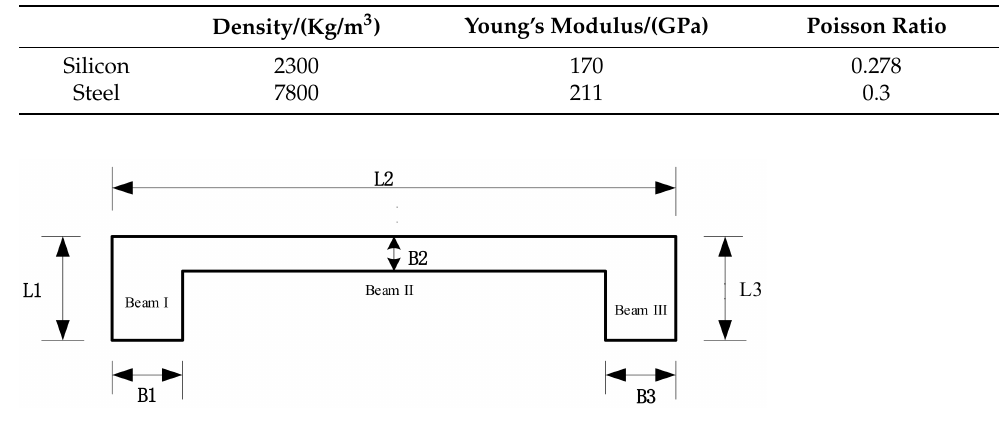
Figure 4. Structural parameters of the resonant